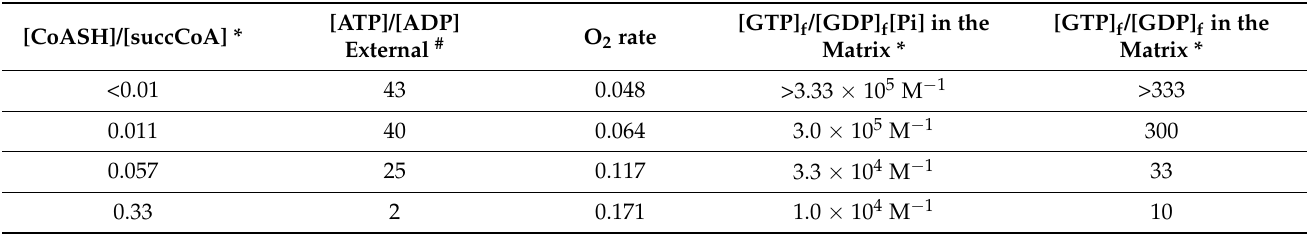
Table 1. Inferring the intramitochondrial [GTP] f /[GDP] f [Pi] by assuming near equilibrium of the succinate thiokinase